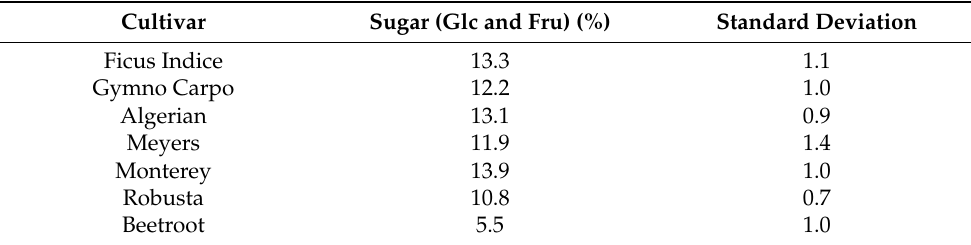
Table 2. ◦ Brix for beetroot 1 and six cactus pear